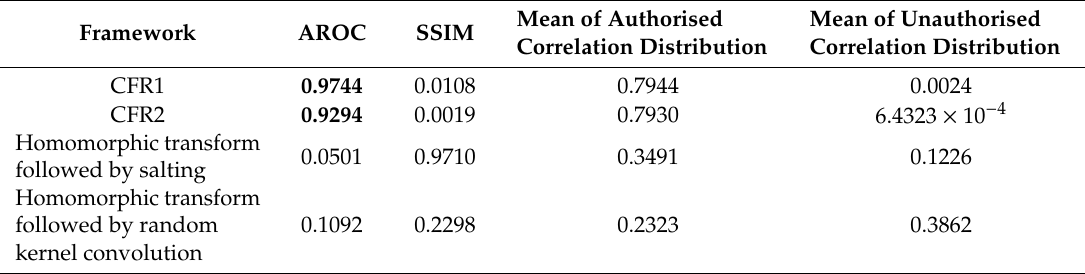
Table 2. Evaluation of CFR frameworks based on FERET dataset (where bold entries indicate best AROC results recorded).